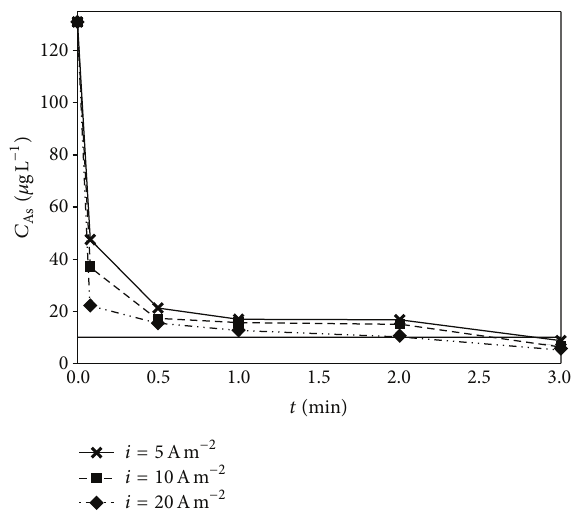
Figure 1: Kinetics of total As removal in the EC reactor for experiments carried out at a flow rate of 0.25 Lmin −1 and current densities of 5, 10, and 20 Am −2